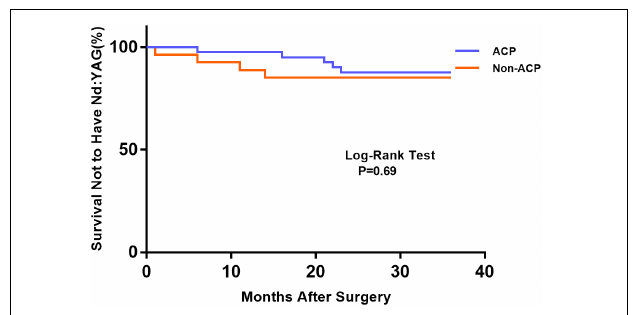
FIGURE 3 | Kaplan–Meier survival plots for eyes by different IOL types (Nd:YAG, neodymium:YAG laser capsulotomy).